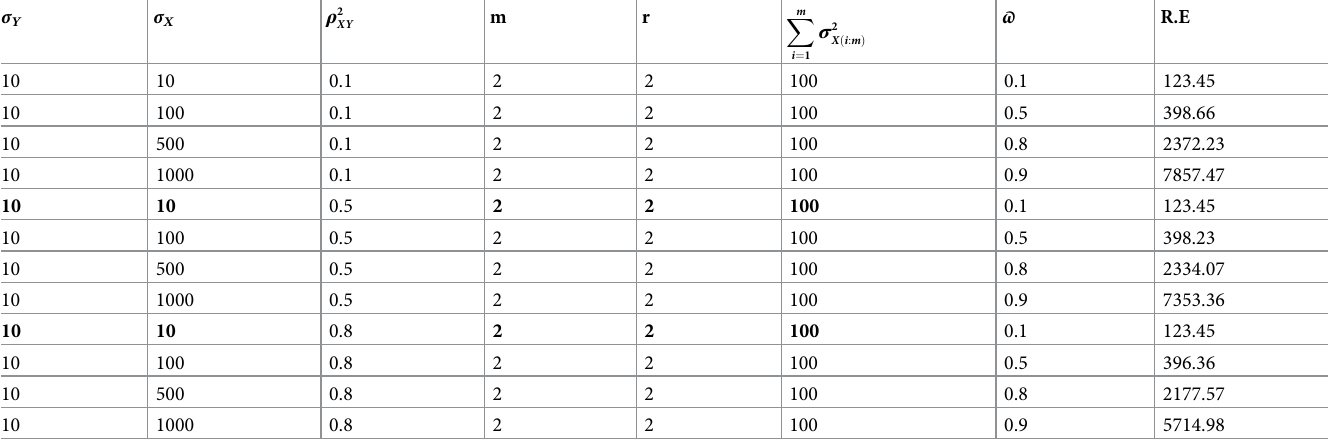
in comparison to ^ μ ; impact of increase in Var(X) and ϖ . NGO : Disclosures IRSS